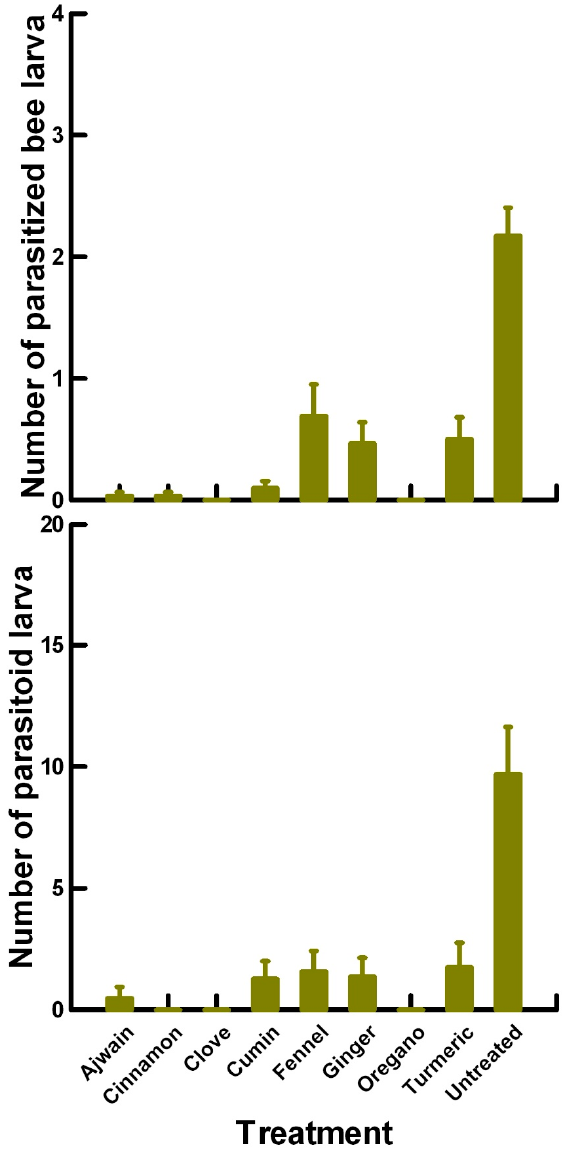
Figure 7. Reproductive toxicity of plant powders (Ajwain, cinnamon, clove, cumin, fennel, ginger, oregano and turmeric) to female P. venustus pre-exposed for 24 hr. Means and standard error